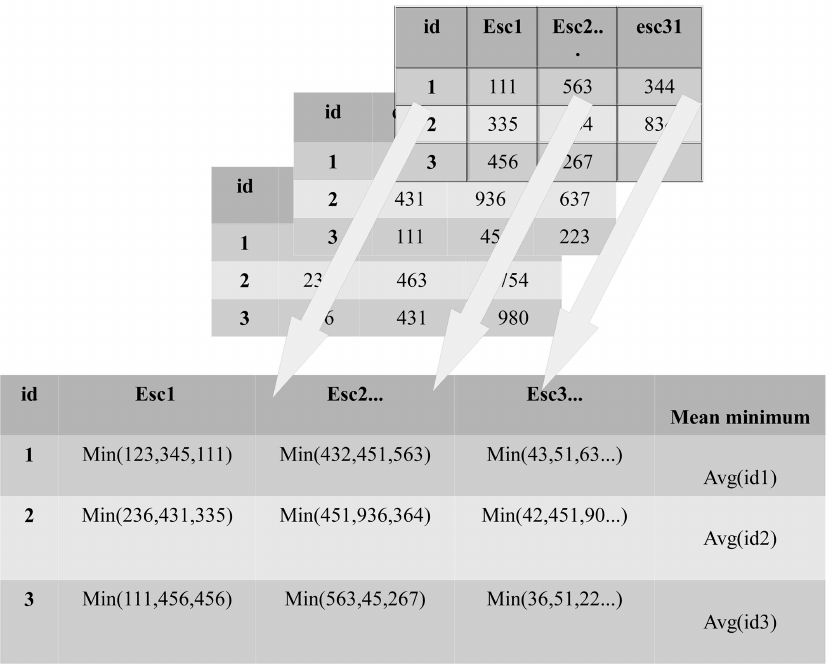
Figure 2. Process for constructing the table of means of the minimum times. Example for the case study ( n = 31 scenarios and m = 3 emergency